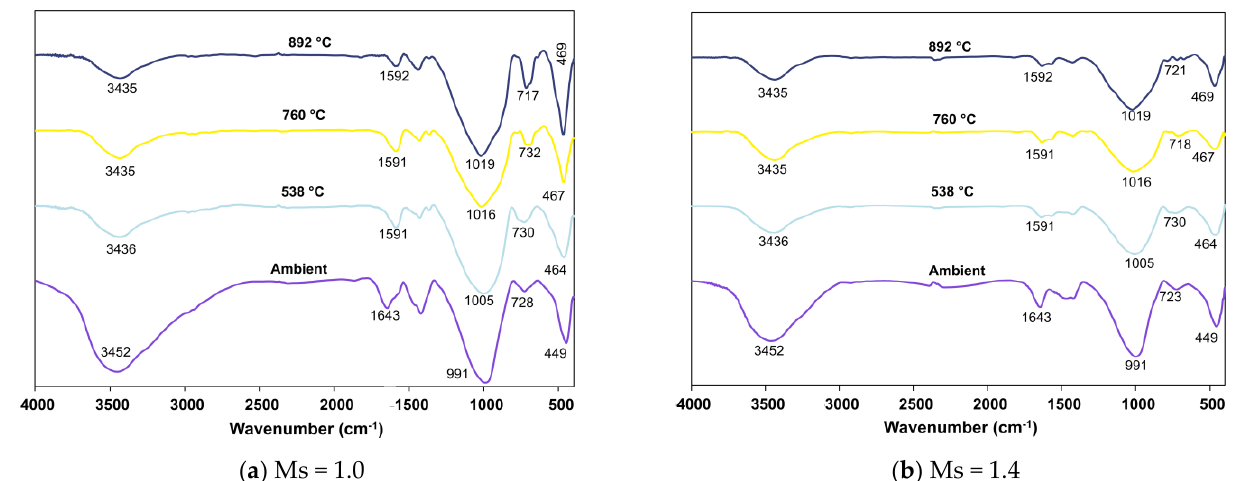
Figure 12. FTIR spectra of FS 40P on exposure to elevated temperature.